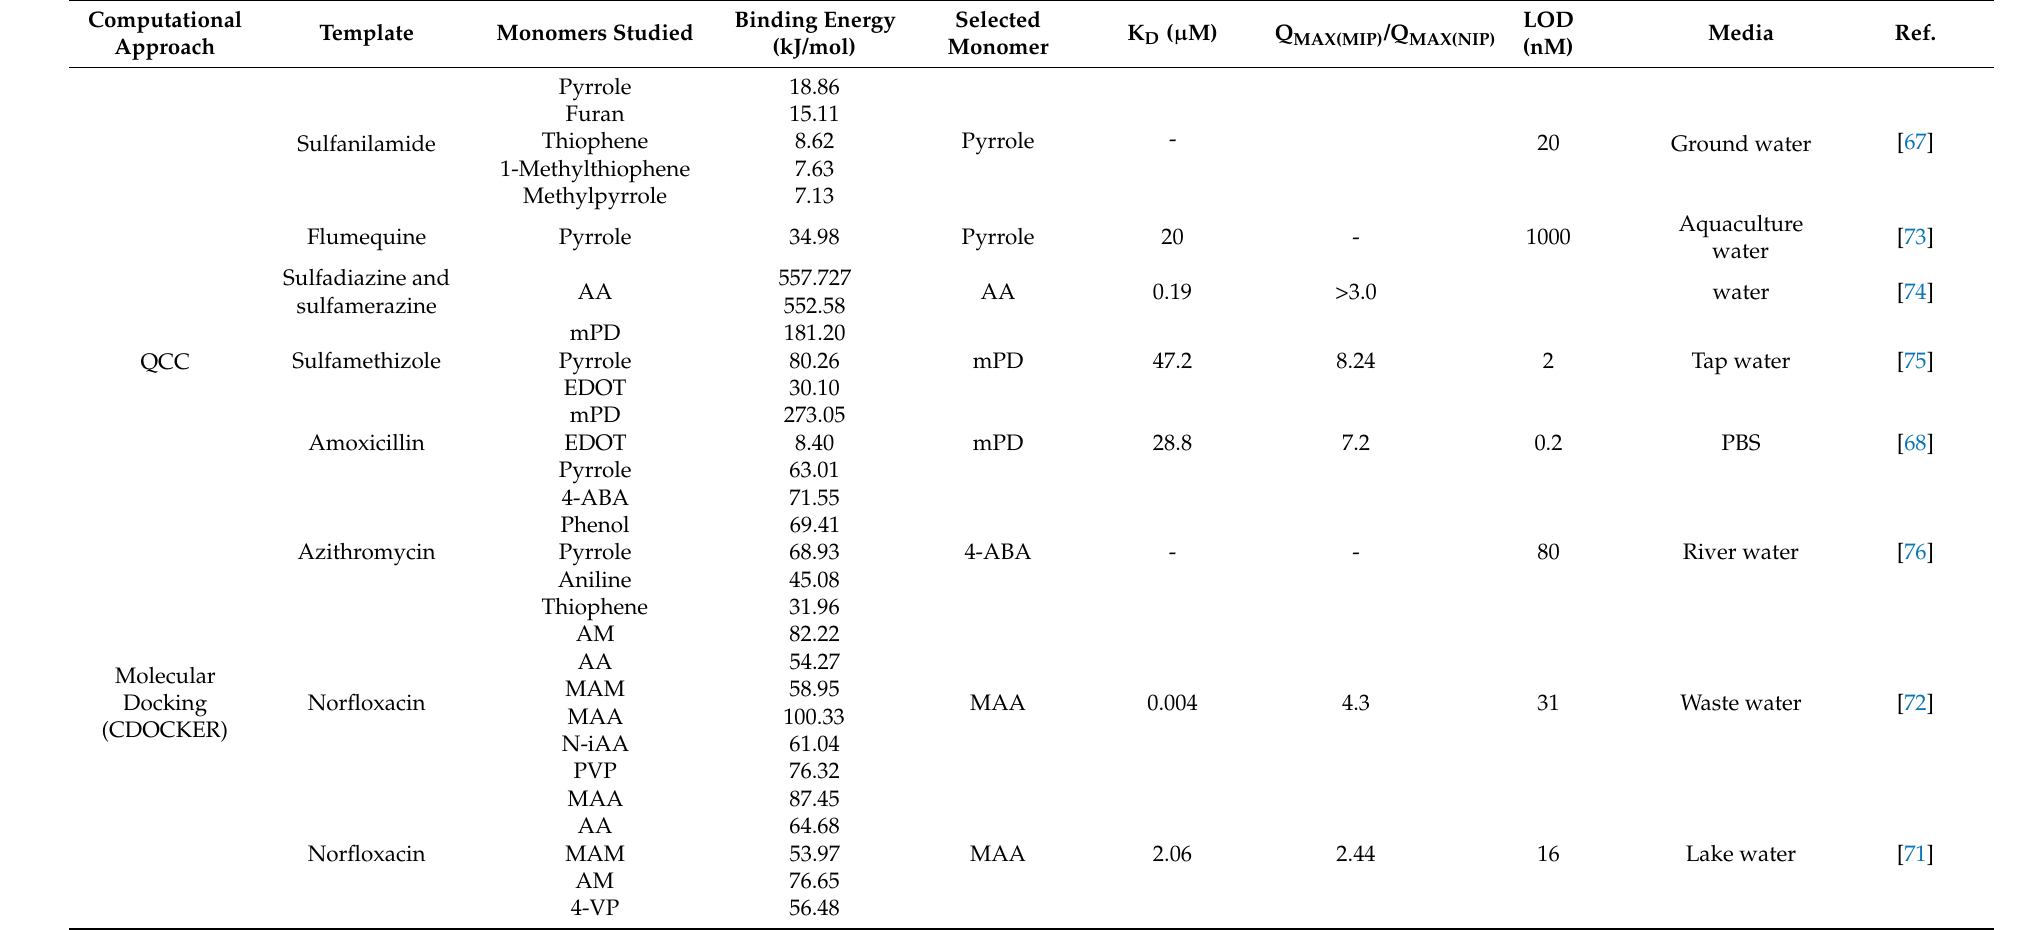
Table 1. Antibiotic MIPs designed by computationally assisted selection of functional monomer and their analytical performances in different aqueous media.